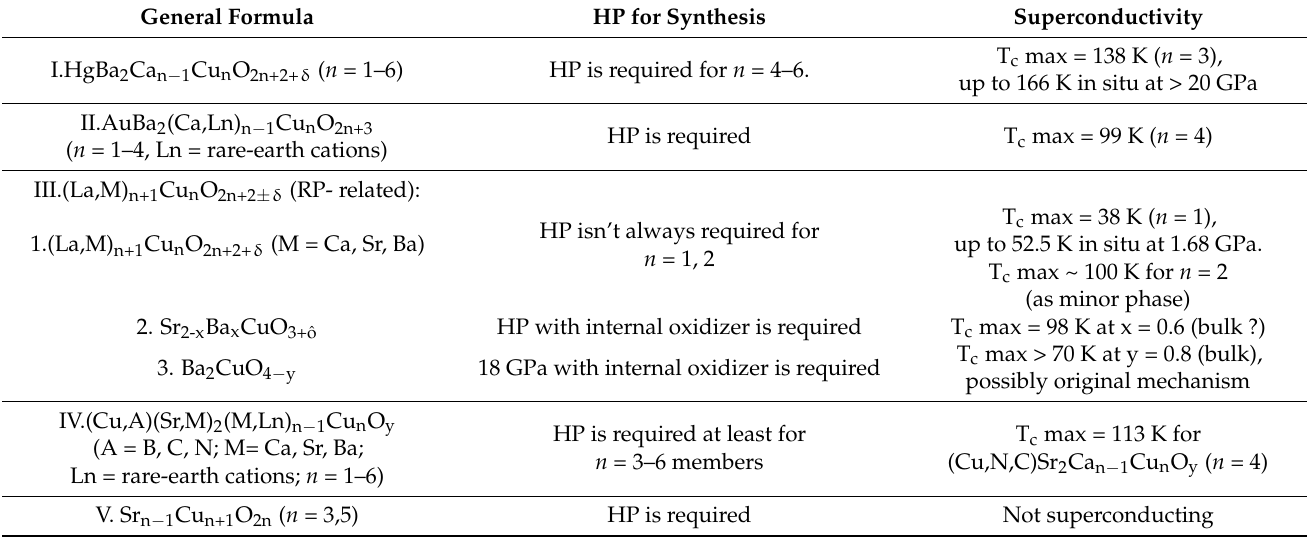
Table 1. Series of cuprates containing structural flat fragments: high-pressure (HP) synthesis and superconductivity. General Formula HP for Synthesis Superconductivity